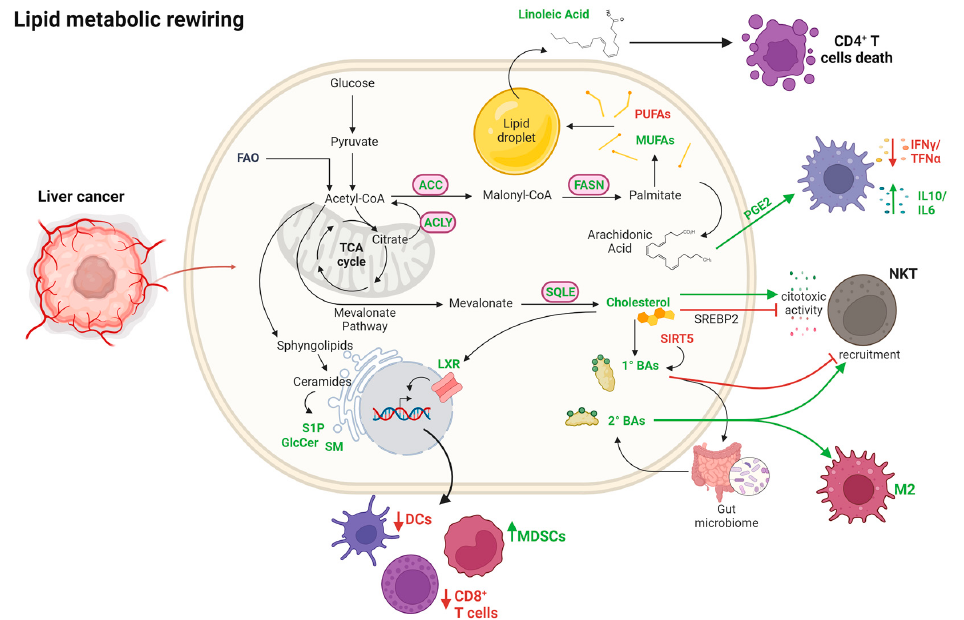
Figure 2. Metabolic rewiring of lipids in liver cancer cells and effects on immune cells infiltration. As illustrated in the review text, deregulation of lipids affects the recruitment and/or the activation of immune cells, potentially favoring immune escape of liver cancer cells. Abbreviations: ACC, acetyl-CoA carboxylase; ACLY, ATP citrate lyase; BAs: bile acids; DCs, dendritic cells; FAO, fatty acids oxidation; FASN, fatty acid synthase; GlcCer, glucosylceramides; M2, M2 macrophage; MDSCs, myeloid-derived suppressor cells; MUFAs, monounsaturated fatty acids; NKT, natural killer T cells; PGE2, prostaglandin E2; PUFAs, polyunsaturated fatty acids; S1P, sphingosine 1-phosphate; SM, sphingomyelin; SQLE, squalene epoxidase; SREBP2, sterol regulatory element-binding protein 2. Legend: green arrows and green bold text indicate up-regulated pathways; red arrows and red bold text indicate down-regulated pathways. Created with BioRender.com.